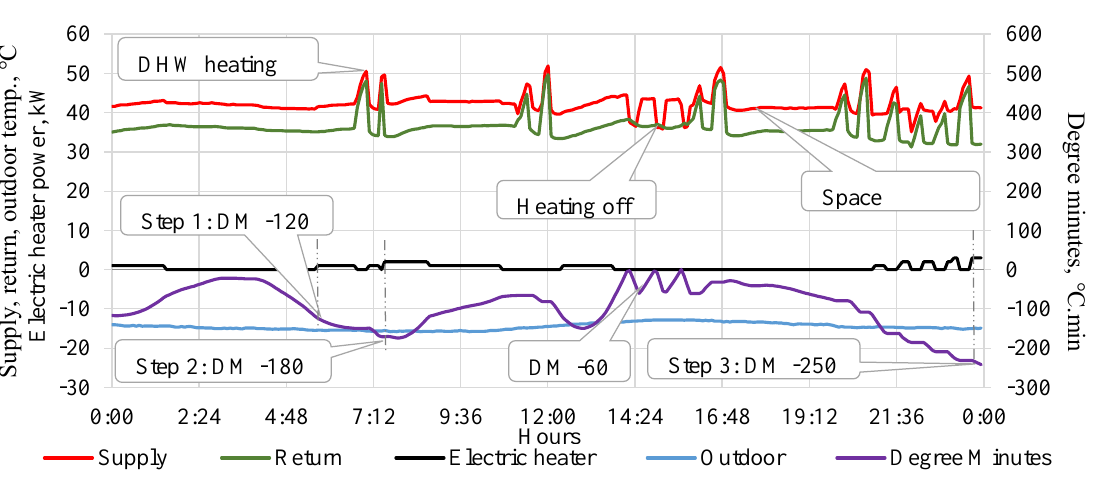
Figure 4. An example of measured GSHP operation: supply temperature, return temperature, outdoor temperature, electric top-up heater power and degree minutes of heat deficit.